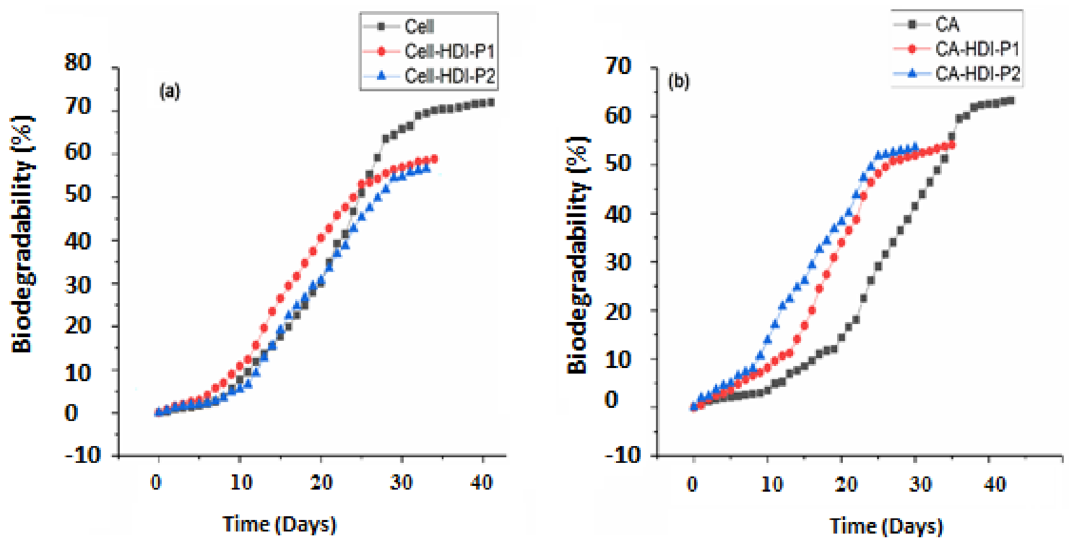
Figure 9. Biodegradation percentage of: ( a ) cellulose, Cell-P 1 , and Cell-P 2 , and ( b ) CA, CA-P 1 , and CA-P 2 at 25 °C under aerobic liquid conditions after incubation period of 40